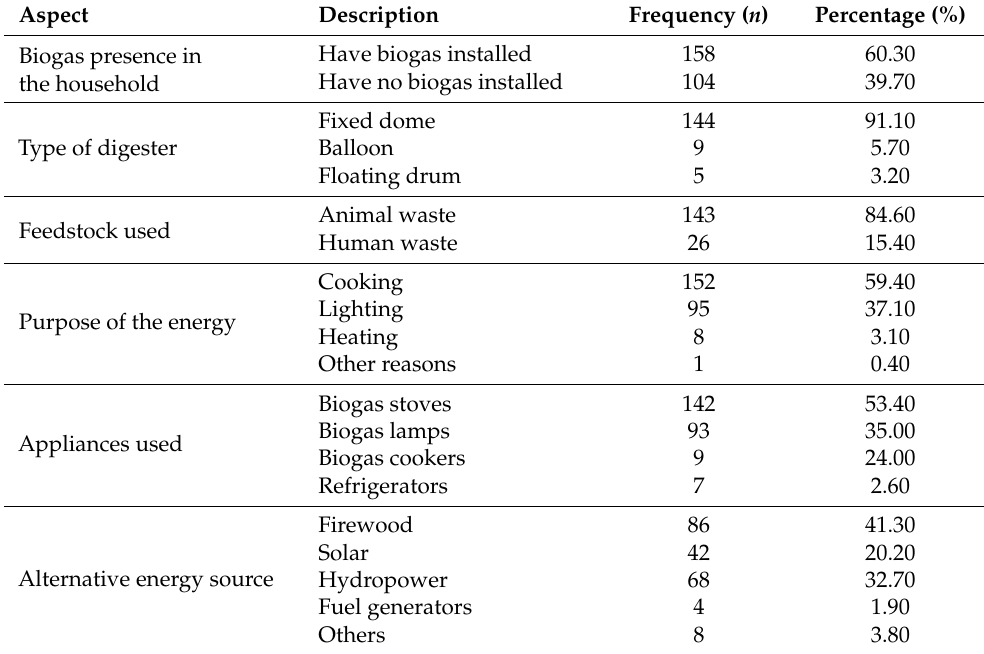
Table 1. Aspects of household biogas production and use.